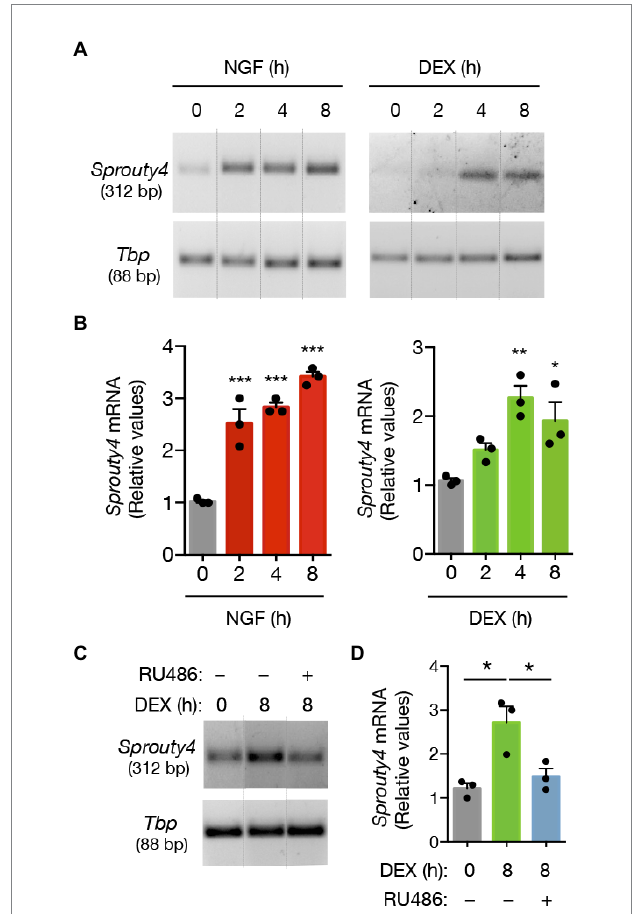
FIGURE 1 DEX promotes the expression of different negative feedback regulators of NGF-induced Ras-Erk1/2/MAPK pathway. (A) Semiquantitative RT- PCR analysis of Sprouty4 mRNA. PC12 cells were treated with DEX (1 μ M) or NGF (50 ng/mL) for different time-points. For each molecule, the PCR amplification product size is indicated in base pairs (bp). (B) Bar graphs showing the induction profiles of Sprouty4 mRNA at different time points upon DEX or NGF stimulation. The levels of mRNA were normalized to the expression of the housekeeping gene Tbp . Values are presented as relative to untreated control group (t = 0 h DEX or NGF). The results are shown as mean ± s.e.m. of n = 3 independent assays. * p < 0.05, ** p < 0.01, *** p < 0.001 by one-way ANOVA followed by Dunnett’s-test. (C) Semiquantitative RT-PCR analysis of Sprouty4 mRNA. For this assay, PC12 cells were pretreated or not with the GR inhibitor RU486 (2 μ M) and then stimulated with DEX (1 μ M) for 8 h. (D) Bar graph showing the blockade of DEX-induced expression